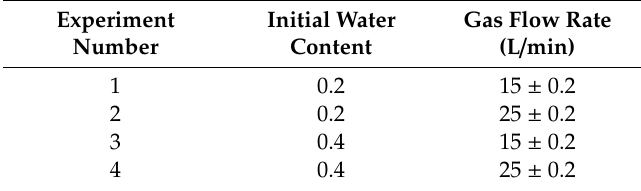
Table 2. Experimental design a